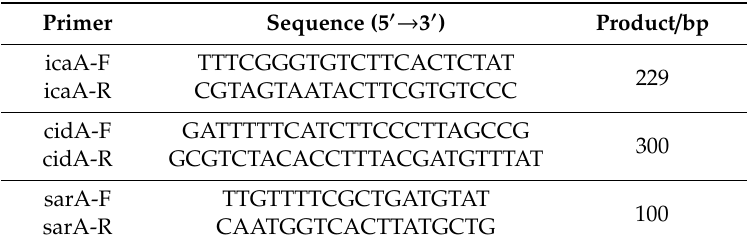
Table 2. Real-time polymerase chain reaction (RT-PCR)